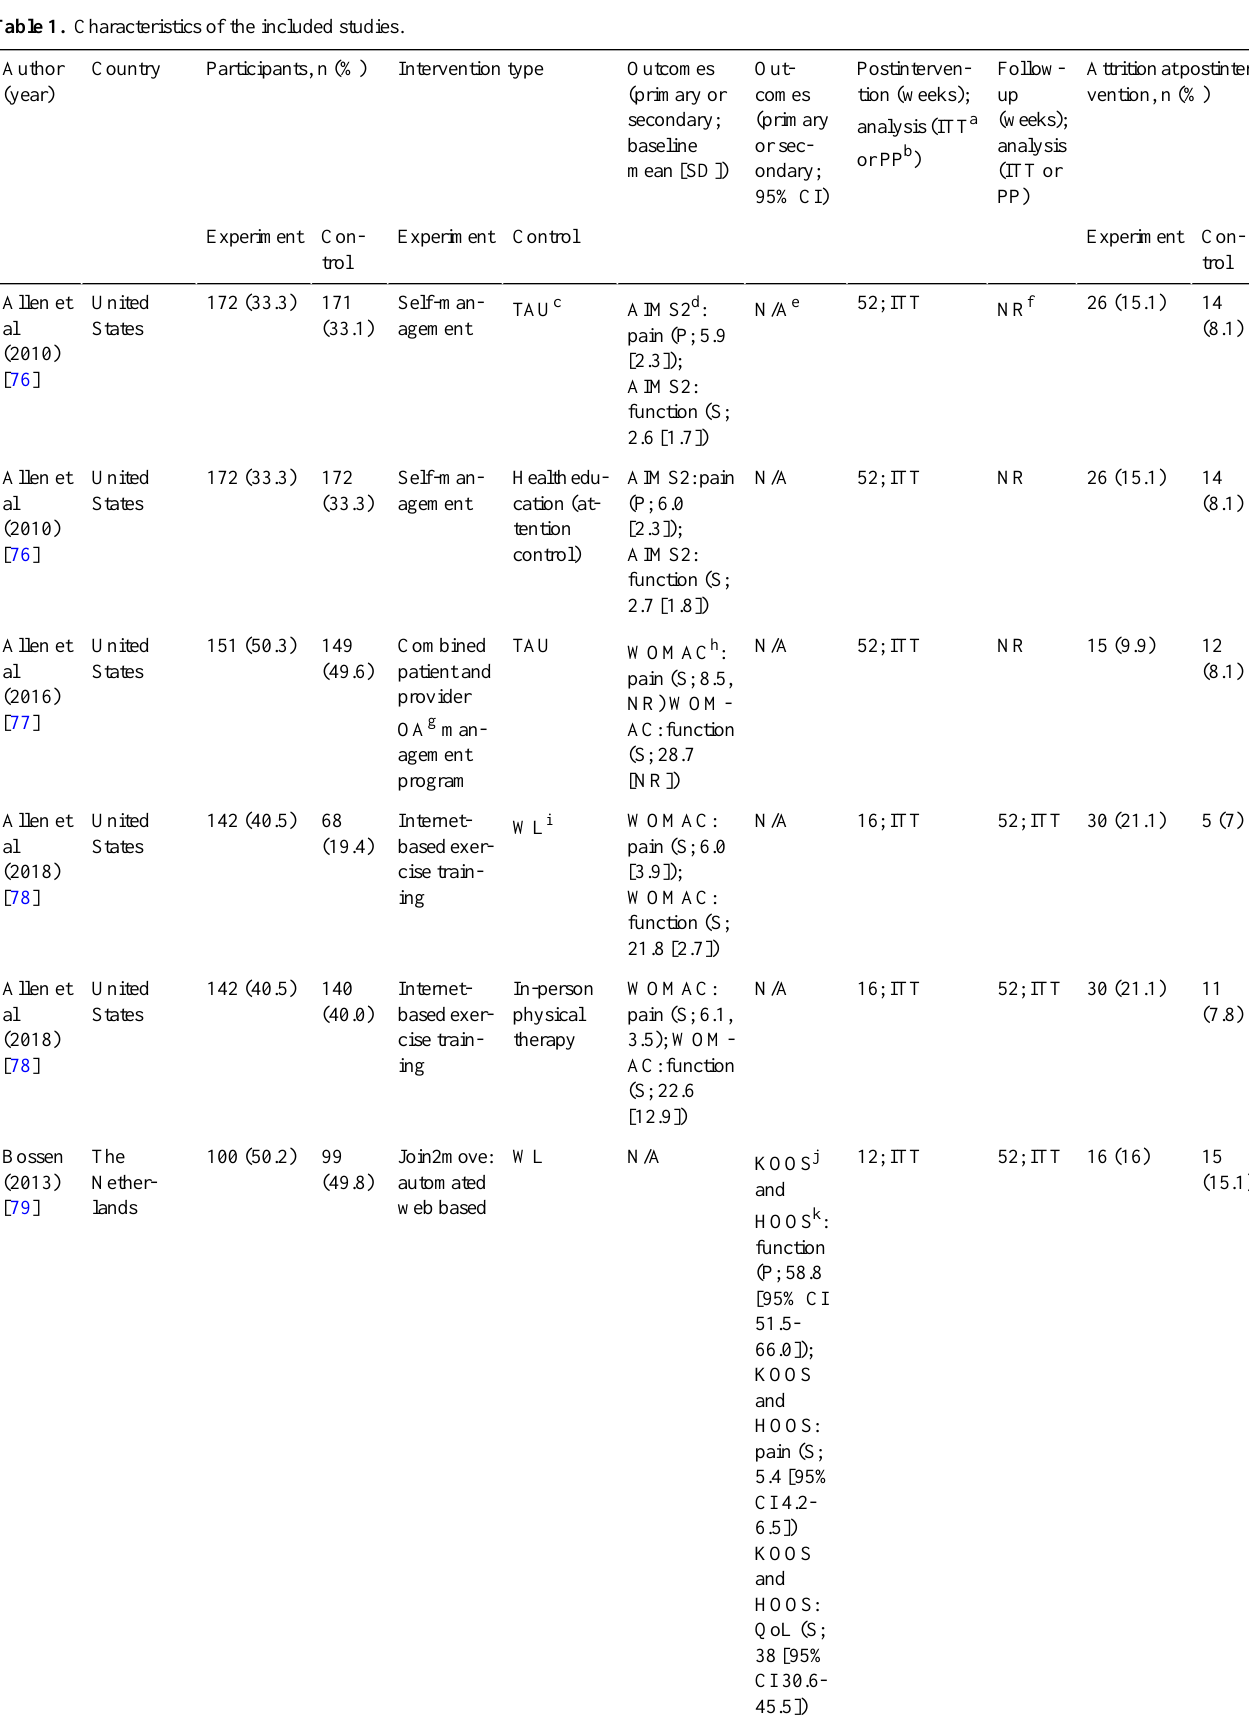
Table 1. Characteristics of the included studies.